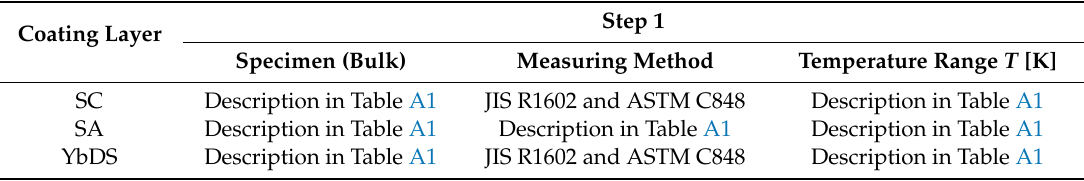
Table A3. Estimation procedure of ν of SiC, SiAlON and YbDS layers (Step 1). Coating